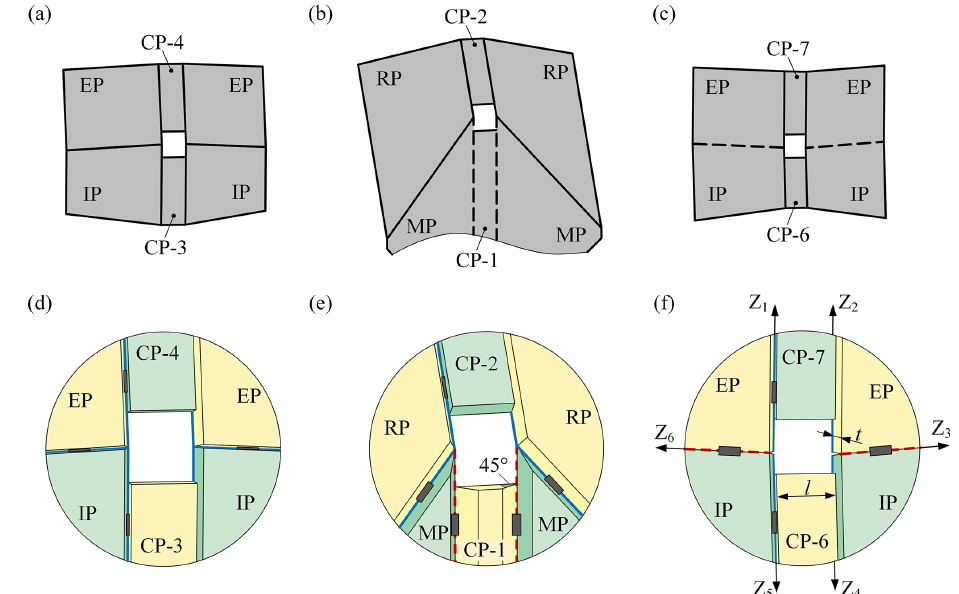
Figure 8. Three types of units in the deployable origami pattern and the corresponding thick-panel model.